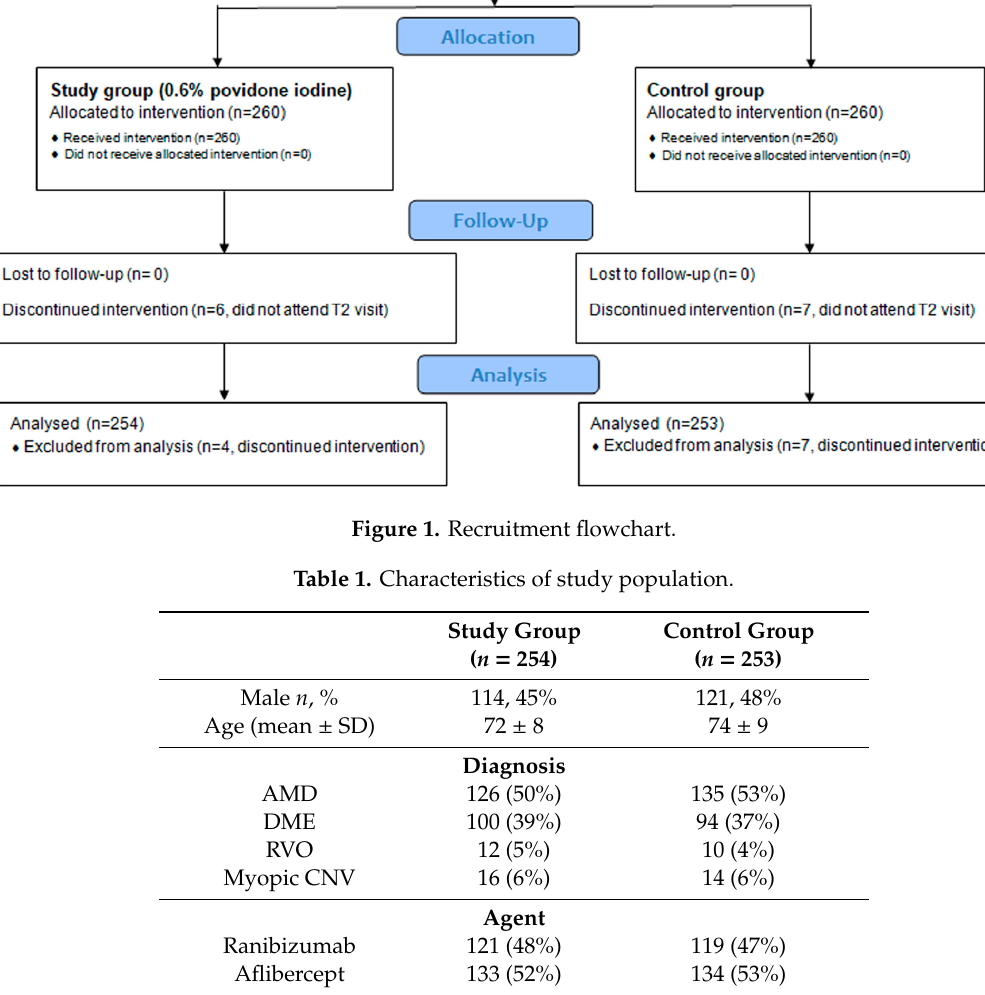
Table 1. Characteristics of study population.